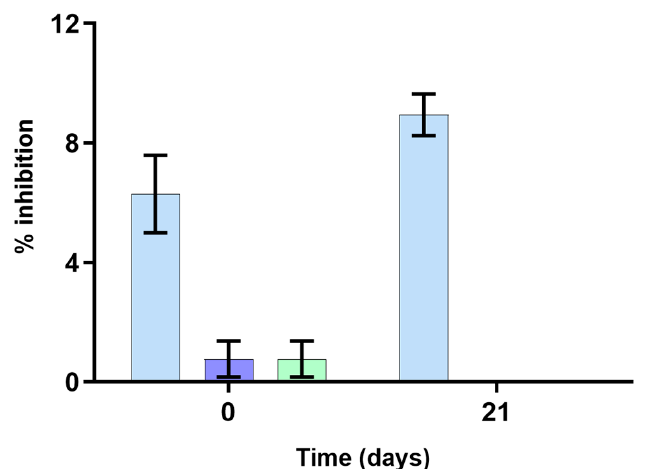
Figure 4. α -Glucosidase inhibitory activity, expressed as the inhibition percentage, of the cheese spread incorporated with Osmundea pinnatifida extract (CSExt, shown by the blue bar), the plain cheese spread (CS, shown by the purple bar), and the cheese spread with FOS (CSFos, shown by the green bar) at 0 and 21 days of refrigerated storage.